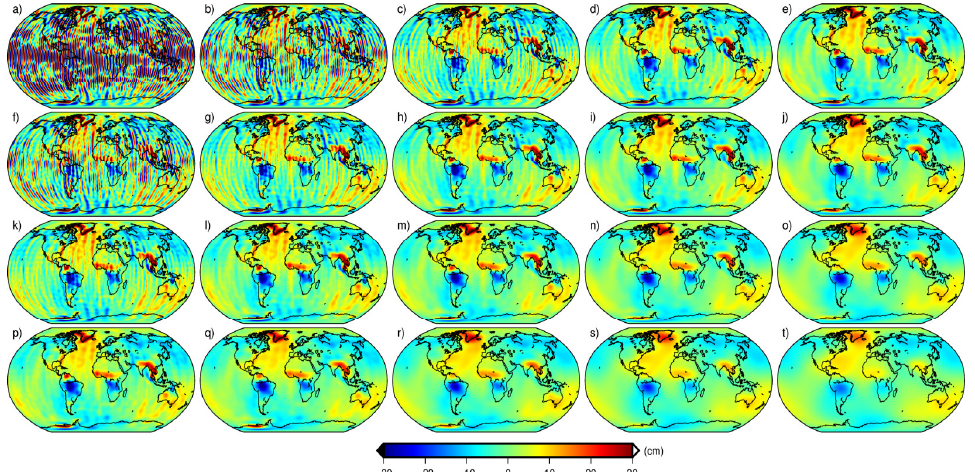
Figure 15. The filtered solution of different regularization coefficients and different power indices with ECM in September 2004. ( a – t ) The regularization coefficients from top to bottom are 1 × 10 15 , 1 × 10 16 , 1 × 10 17 and 1 × 10 18 , respectively. The power indices of SCMs from left to right are 4.0, 4.5, 5.0, 5.5, and 6.0, respectively.